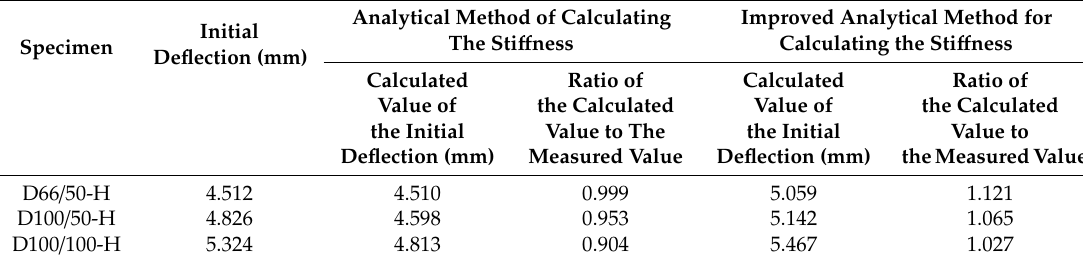
Table 7. Calculated initial deflection of the specimens with RFAs by the improved analytical method for calculating the sti ff